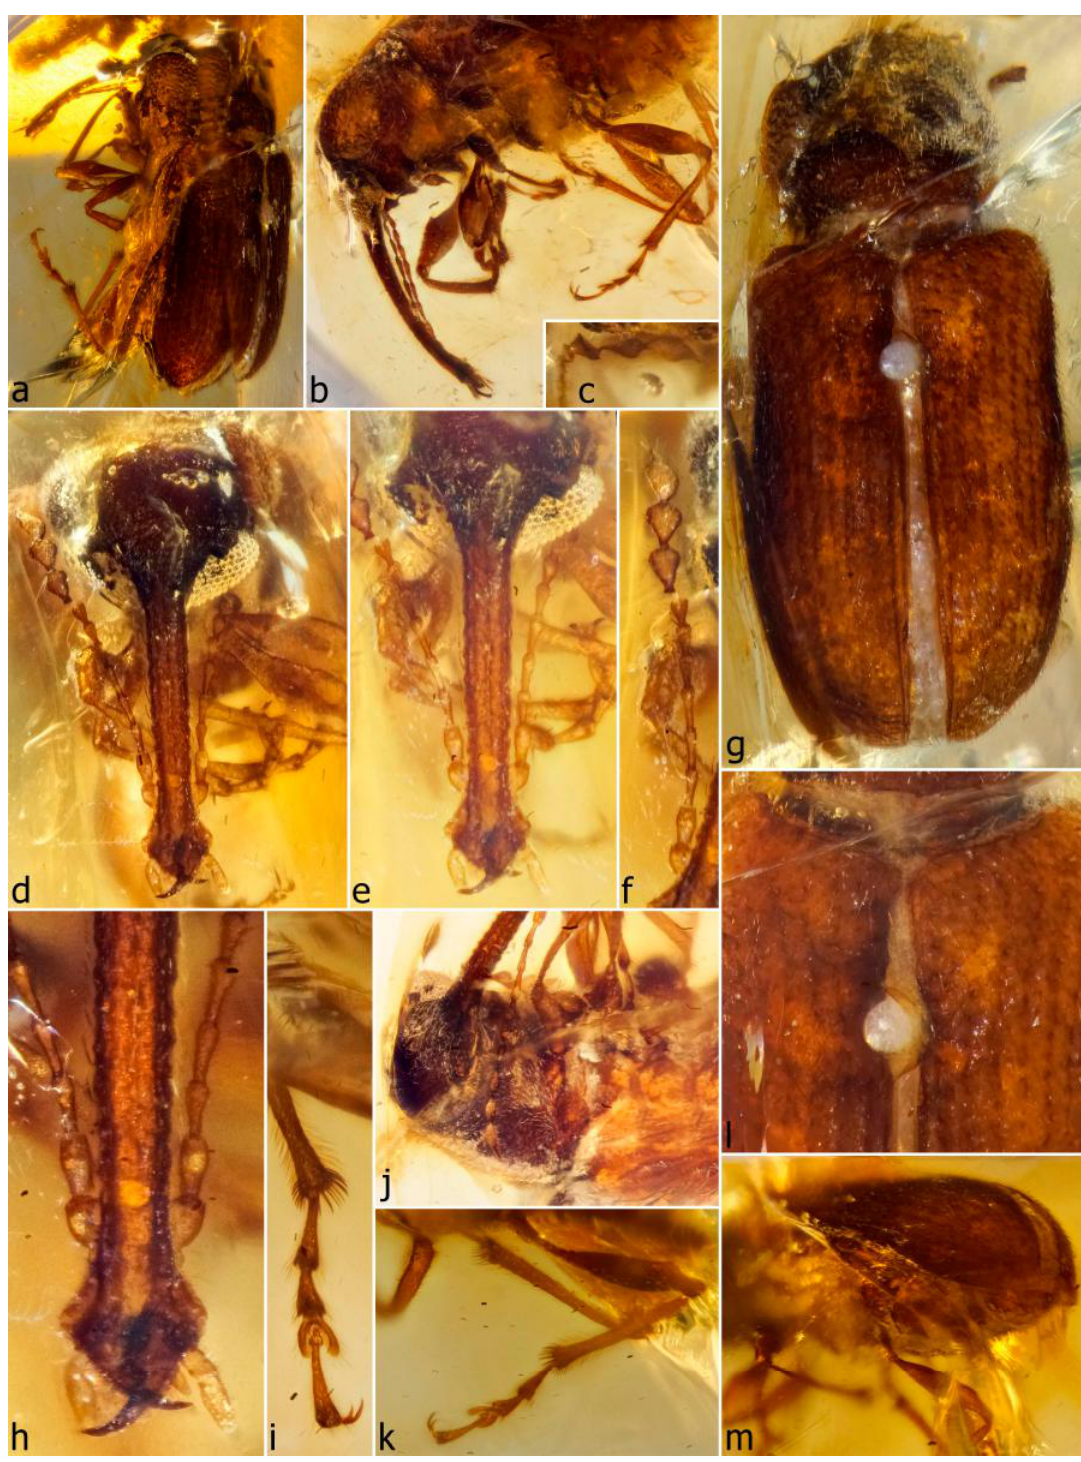
Figure 14. Burmonyx zigrasi , holotype. Habitus, left lateral ( a ); head and prothorax, left lateral ( b ); left antennal club, left lateral ( c ); head, dorsal ( d ); same, showing details of head and eyes ( e ); right antenna, dorsal ( f ); habitus, dorsal ( g ); detail of rostrum and mandibles, dorsal ( h ); left metatarsus, dorsal ( i ); head, prothorax and mesothorax showing closed coxal cavities, right lateroventral ( j ); left hindleg, anterior (outer) ( k ); detail of elytral striation showing scutellary striole, dorsal ( l ); elytral and abdominal apex, laterocaudal ( m ).